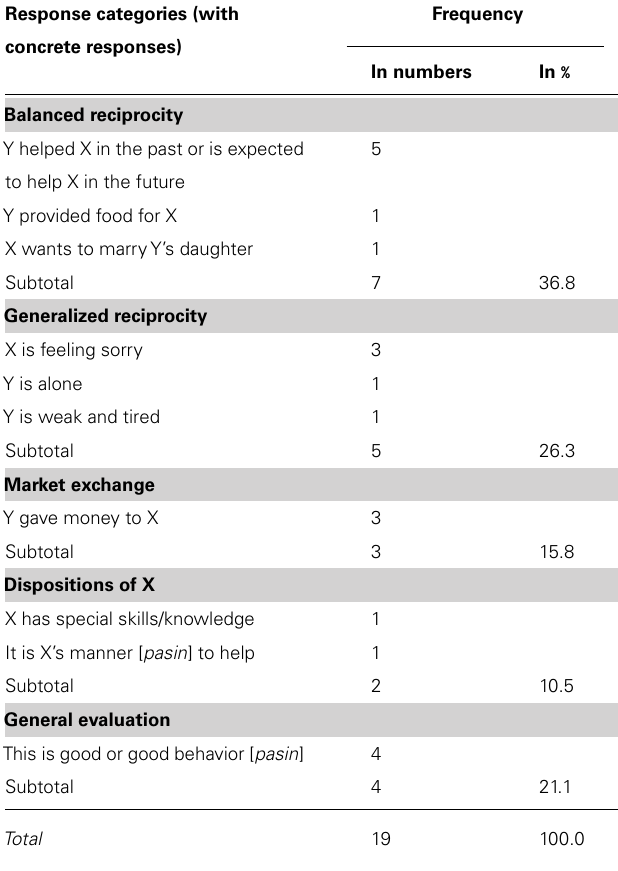
Table 1 | Explanations for social interaction: